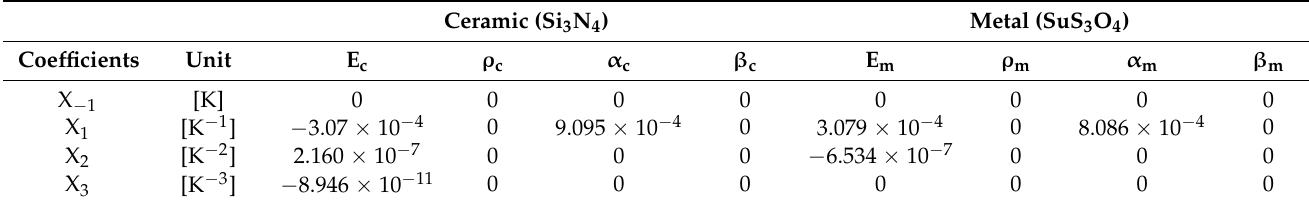
Table 2. Coefficients of material phases ( X − 1 , X 1 , X 2 , X 3 ) for ceramic (Si 3 N 4 ) and metal (SuS 3 O 4